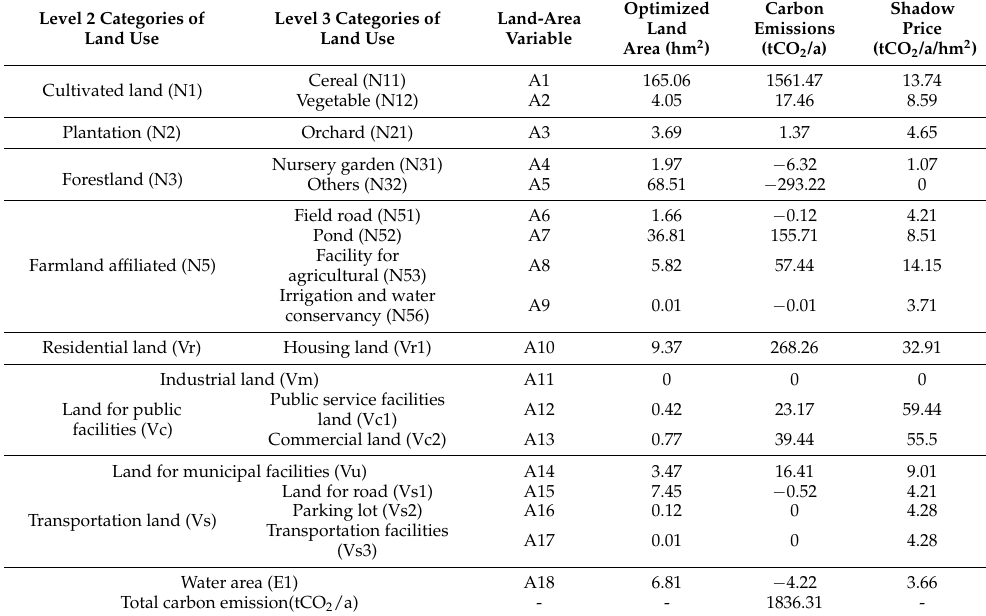
Table 6. Optimization